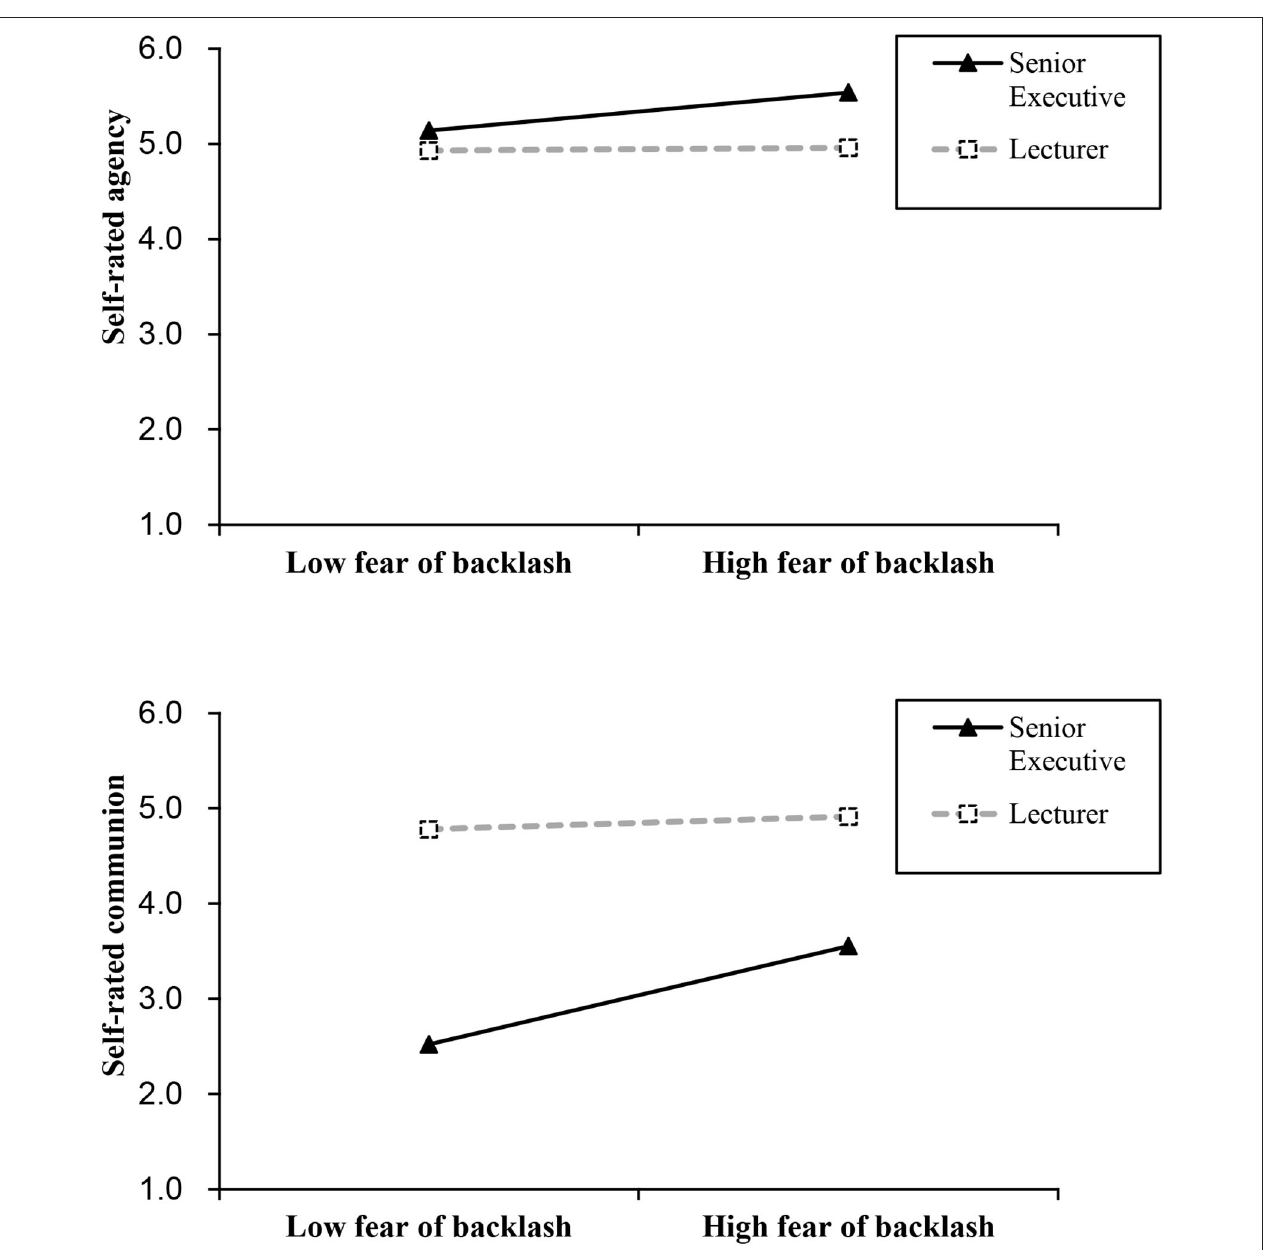
FIGURE 3 | Simple slope analysis for moderation effect of fear of backlash on the relationship between the role type of women and self-reported agency and communion in Study 2 under imagination research paradigm. N = 207 women ( N Executive = 104, N Lecturer =